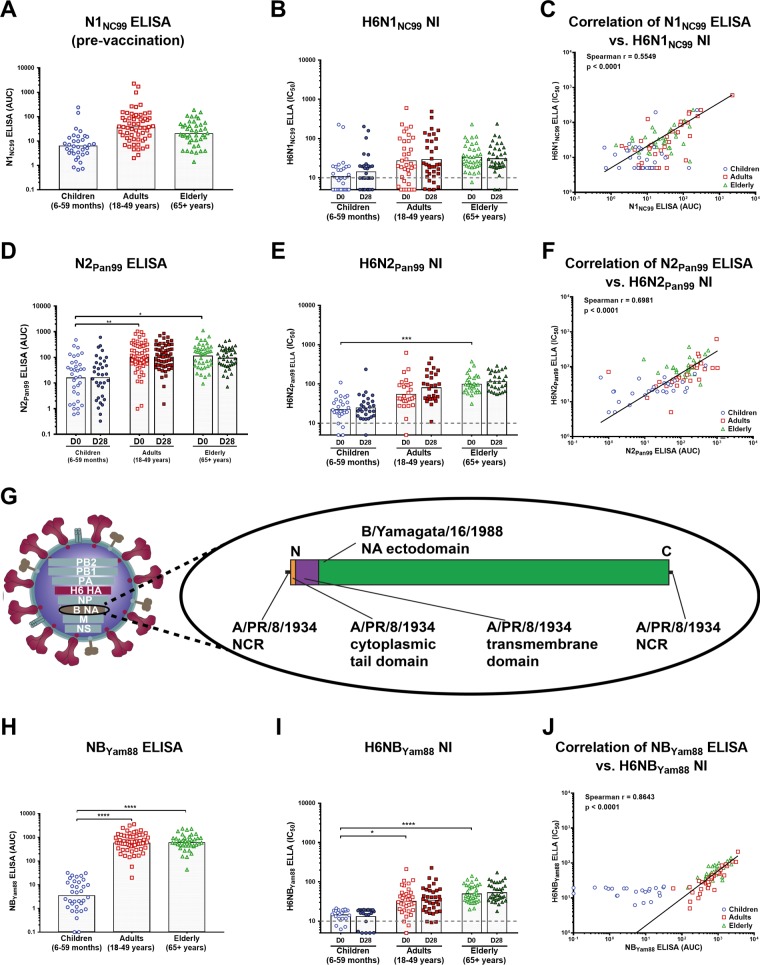
Relationship between binding and functionality of antibodies against prepandemic seasonal N1, N2, and type B influenza virus NA. (A and B) Geometric mean titers for children, adults, and the elderly against recombinant NC99 N1 as measured by ELISA (prevaccination, shown as the area under the curve [AUC]) (A) and ELLA titers (pre- and postvaccination, shown as IC50 values) against H6N1NC99 virus (B). The dashed line indicates the starting serum dilutions used in the ELLA assays. (C) Correlation between NC99 N1 ELLA and ELISA titers (Spearman r = 0.5549, P < 0.0001). (D and E) The same analyses were also performed for anti-N2 antibodies with recombinant Pan99 N2 as an ELISA substrate (pre- and postvaccination) (D) and H6N2Pan99 as an ELLA reagent (pre- and postvaccination) (E). D, day. (F) Similarly to the data determined with N1, the binding and functional titers against Pan99 N2 correlated well (Spearman r = 0.6981, P < 0.0001). (G) Design of the H6NBYam88 virus that was rescued specifically for this study. The virus is a reassortant virus that combines the internal genes of H1N1 virus A/PR/8/34, an H6 HA, and a chimeric NA. The NA consists of the ectodomain of the B/Yamagata/16/1988 NA combined with the cytoplasmic tail and transmembrane domains from the A/PR/8/34 N1 NA. The open reading frame is flanked by 5′ and 3′ noncoding regions (NCRs) of the A/PR/8/34 NA. (H and I) Geometric mean titers for children, adults, and the elderly against recombinant Yam88 NB as measured by ELISA (prevaccination) (H); ELLA titers (pre- and postvaccination) against the novel H6NBYam88 virus (I). (J) Relationship between binding and functional Yam88 NA titers (Spearman r = 0.8643, P < 0.0001).